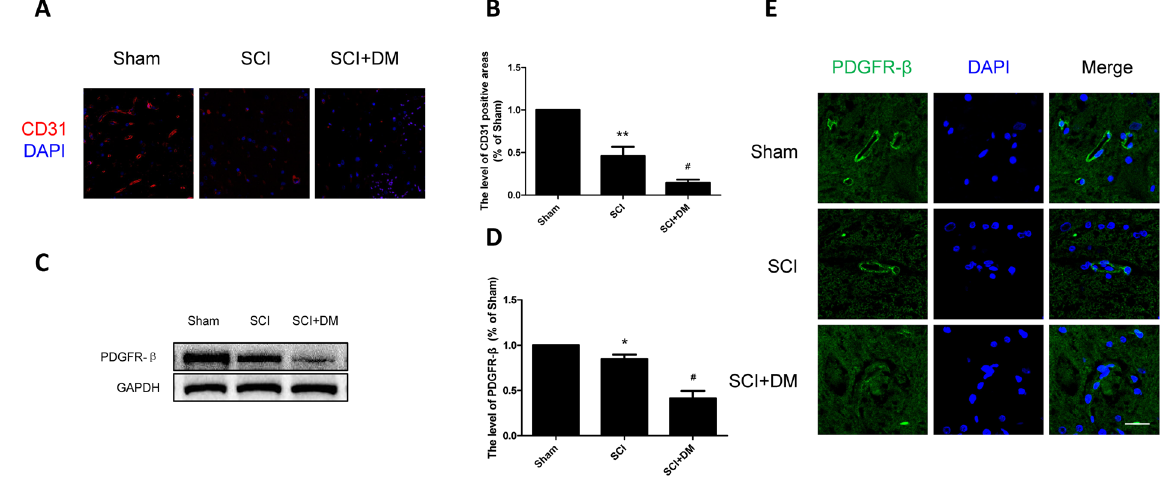
Figure 2. DM aggravates microvessels loss and decreases pericyte coverage after SCI. ( A , B ) Immunofluorescence staining of CD31 and quantification of the level of CD31 positive areas in each group, n = 4. Scale bar = 50 μ m. ( C , D ) Western blot and quantification of PDGFR- β in each group, n = 6. ( E ) Immunofluorescence staining of PDGFR- β in each group, n = 4. Scale bar = 10 μ m. * p < 0.05, ** p < 0.01 vs sham group, # p < 0.05 vs SCI